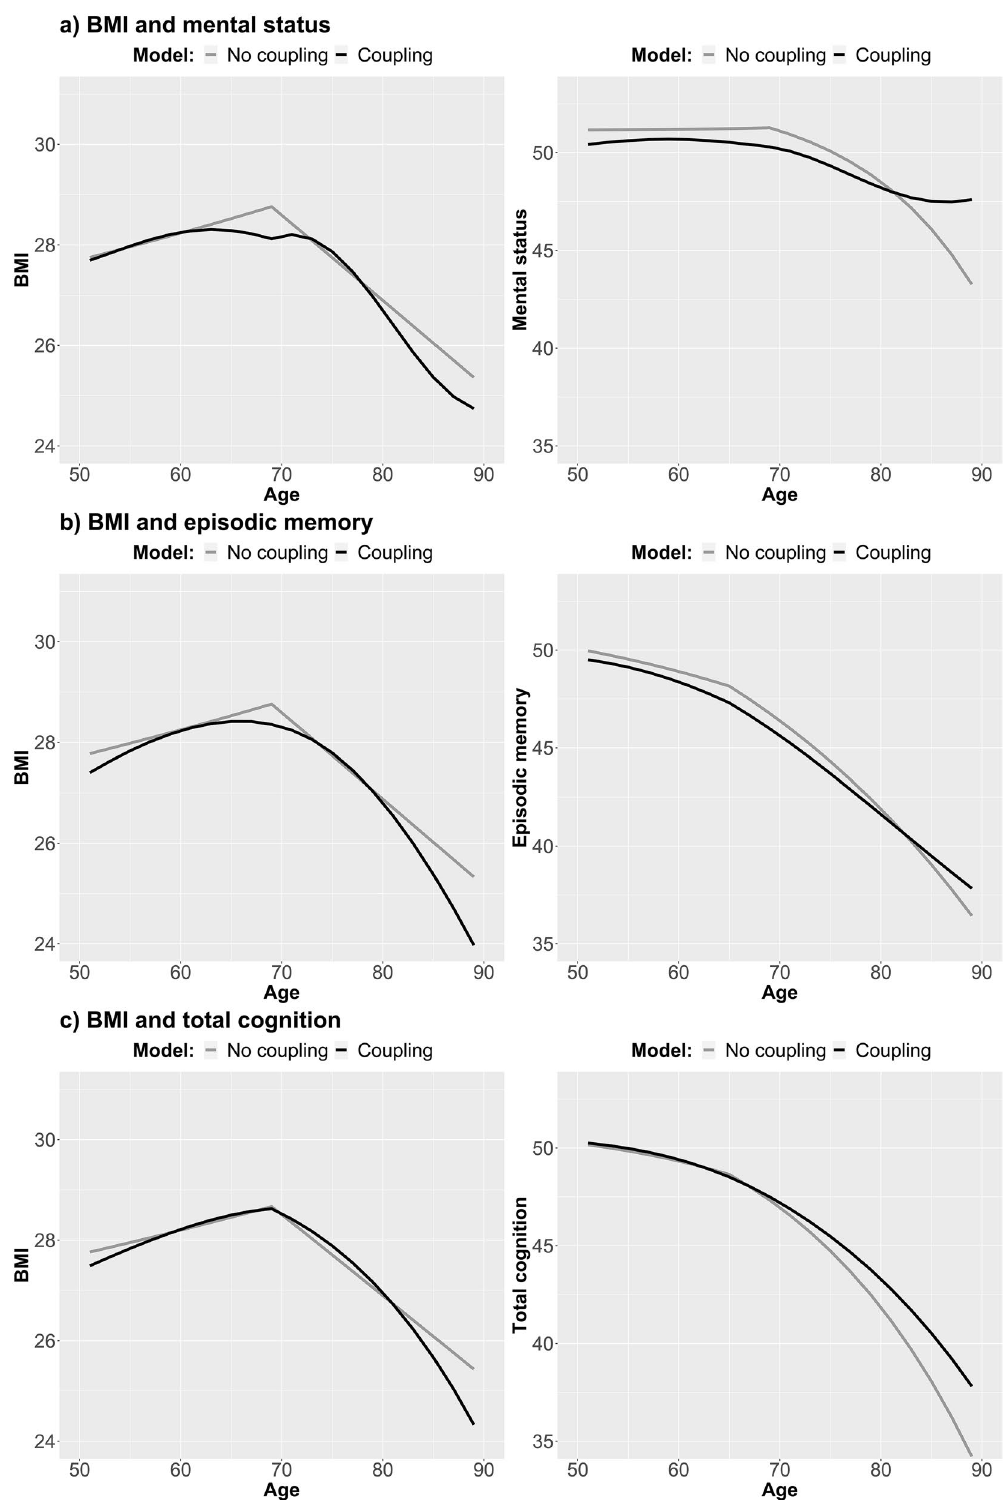
Figure 2. Longitudinal trajectories from bivariate dual change score models, showing change in BMI and cognitive abilities with and without the bivariate coupling-parameter. Trajectories from the full coupling model are shown in black, and those from the no-coupling model in grey. Models were adjusted for sex and education, and a breakpoint in the proportional change parameter added at age 70 for BMI and mental status, and at 65 for episodic memory and total